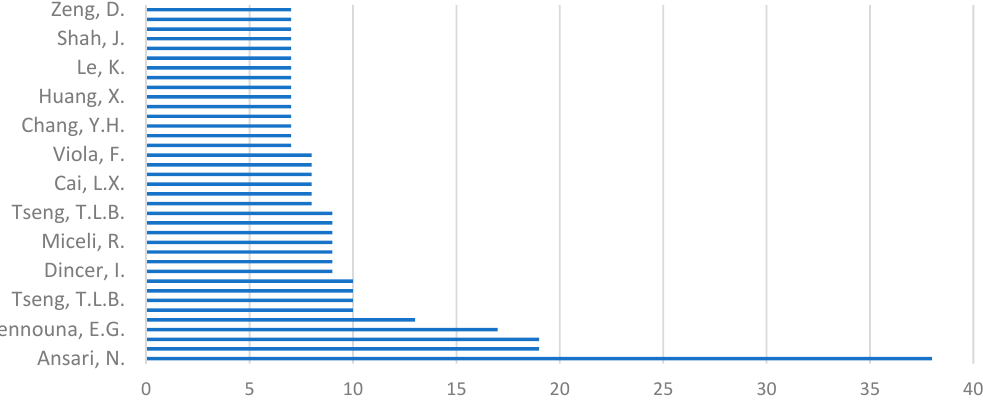
Figure 2. The Top 10 scientists who research the issues of green electricity production technology (source: developed by the author based on Scopus).